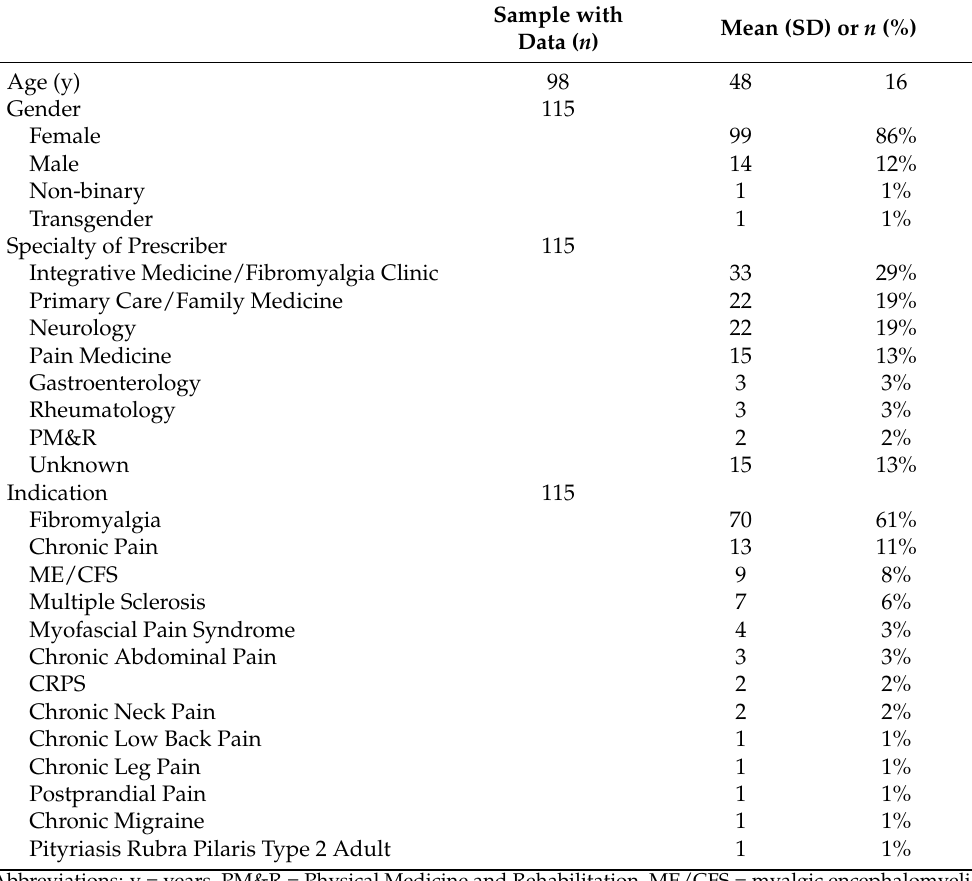
Table 1. Patient and Prescription Characteristics ( n = 115).